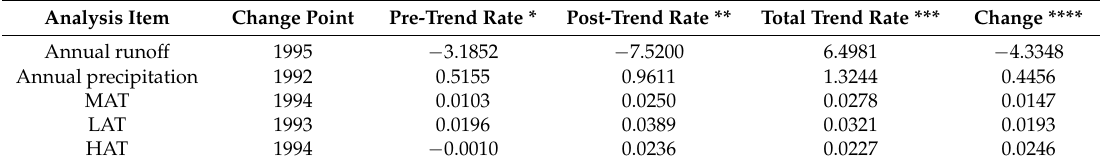
Table 2. Results of abrupt change of annual runoff, annual precipitation and temperature (MAT, LAT and HAT).